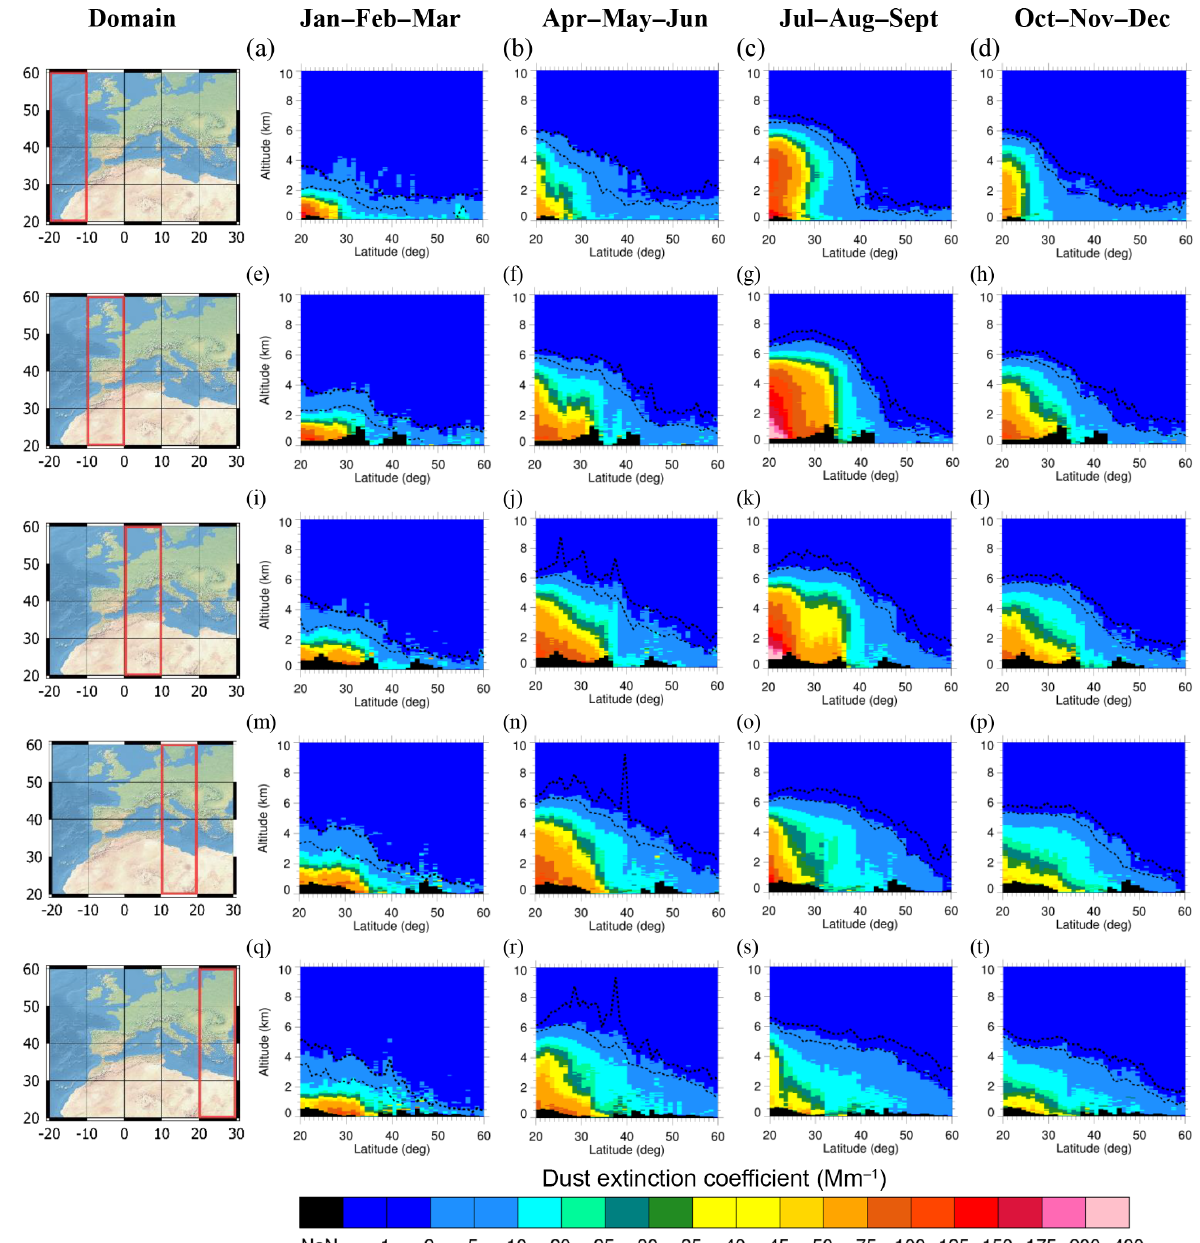
Figure 5. Geographical zonal distribution of the climatological dust extinction coefficient values (Mm − 1 ) measured by the CALIPSO dust product for the regions 10 to 20 ◦ W (a–d) , 0 to 10 ◦ W (e–h) , 0 to 10 ◦ E (i–l) , 10 to 20 ◦ E (m–p) and 20 to 30 ◦ E (q–t) for the latitudinal regions from 10 to 60 ◦ N as illustrated by domain maps for the 3-month averages: January–March (a, e, i, m, q) , April–June (b, f, j, n, r) , July–September (c, g, k, o, s) and October–November (d, h, l, p, t) . The median surface elevation is depicted with black